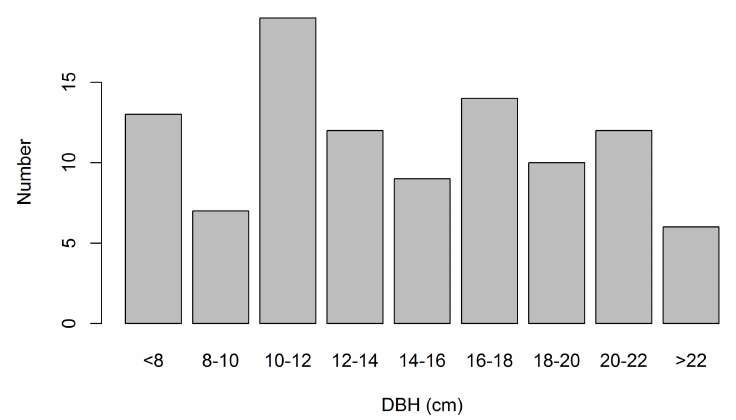
Figure 1. Distribution of the values of the tree diameter at breast height (DBH) in the study